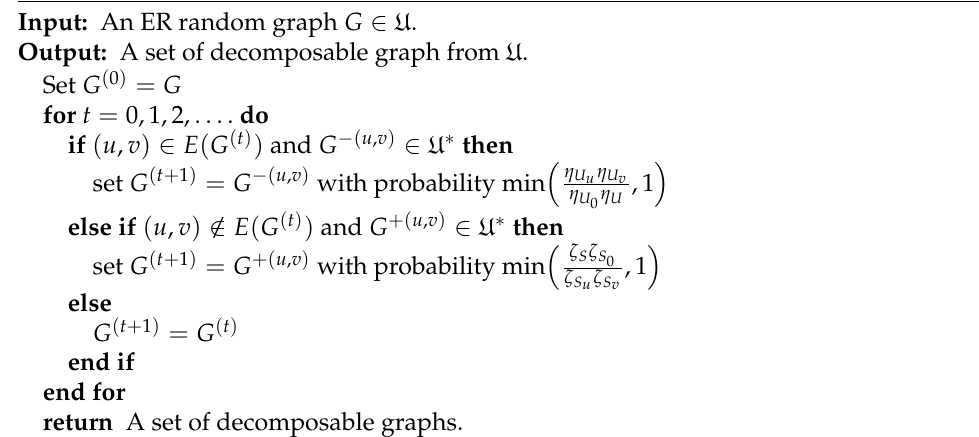
Algorithm 1 A Metropolis–Hastings algorithm for sampling decomposable graphs from a structural Markov graph